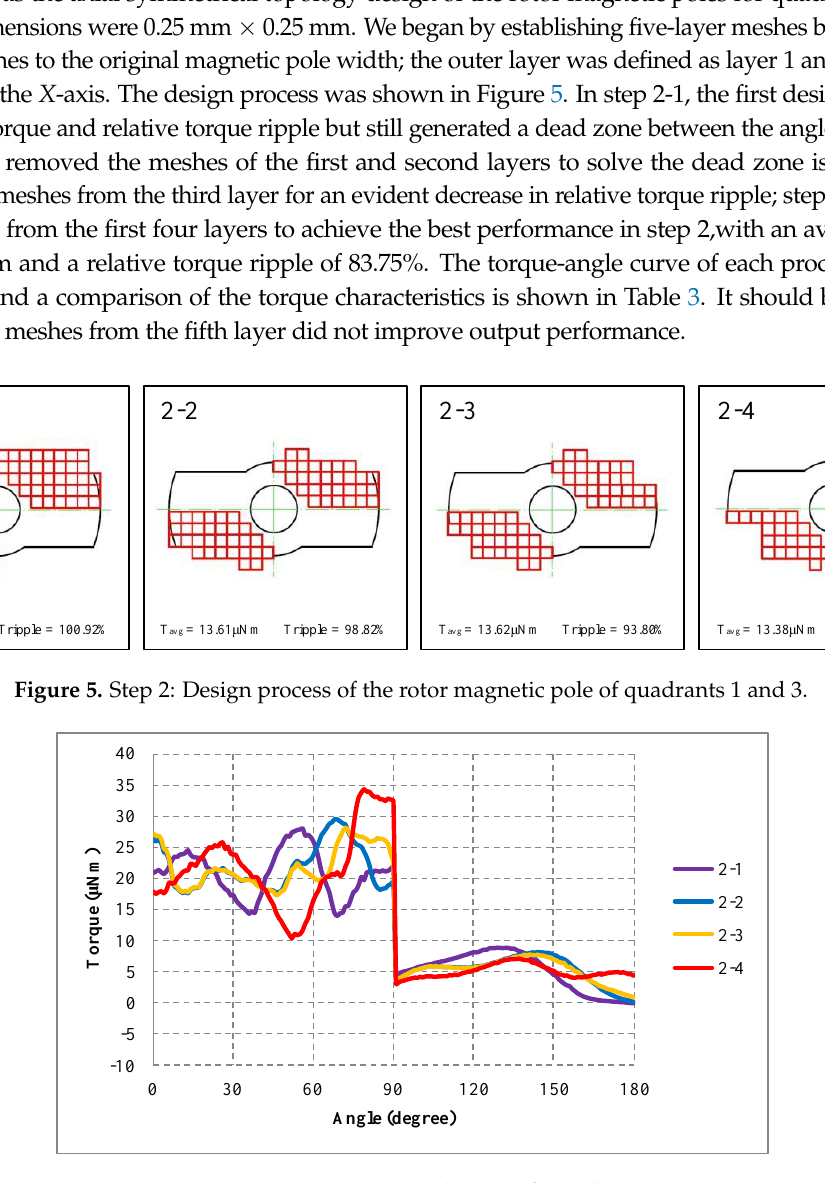
Figure 6. Step 2: Torque-angle curve for each step.